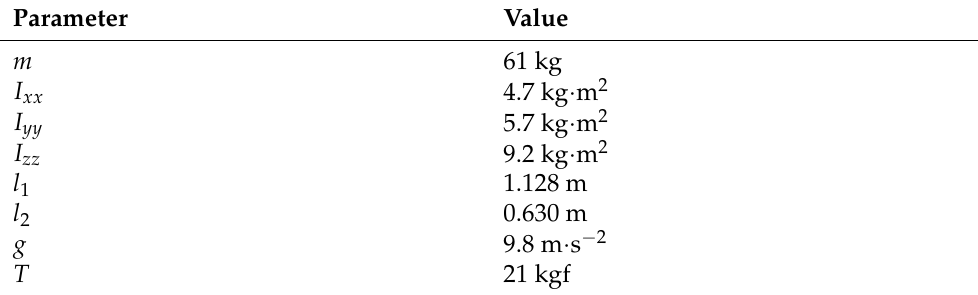
Table 5. Parameters of the aircraft